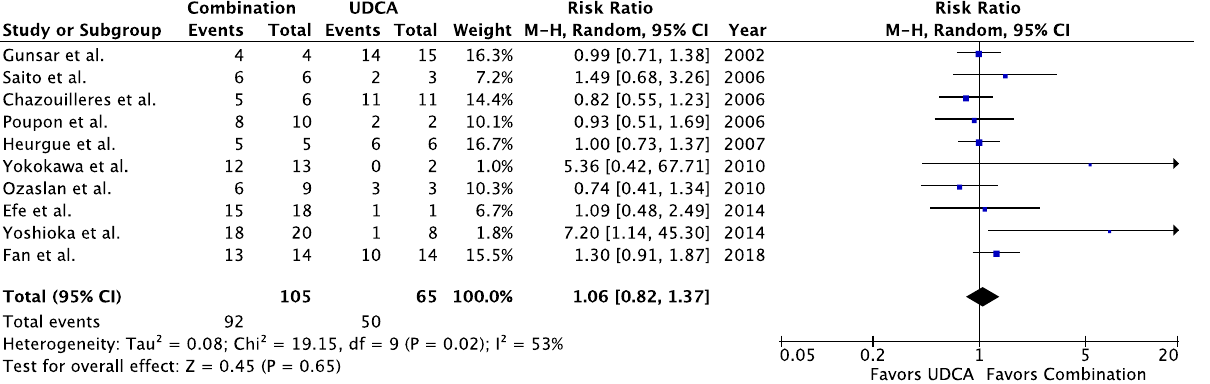
Figure 4. Transplant-free survival in AIH-PBC patients treated with combination therapy vs. UDCA alone. UDCA = ursodeoxycholic acid, Combination = UDCA + Figure A4. Biochemical improvement in AIH-PBC patients treated with combination therapy vs. UDCA alone, including only those studies in which biochemical [corticosteroids and/or antimetabolites]. improvement was defined by both hepatocellular and cholestatic markers. UDCA = ursodeoxycholic acid, Combination = UDCA + [corticosteroids and / or antimetabolites]. J. Clin. Med. 2020 , 9 , x FOR PEER REVIEW